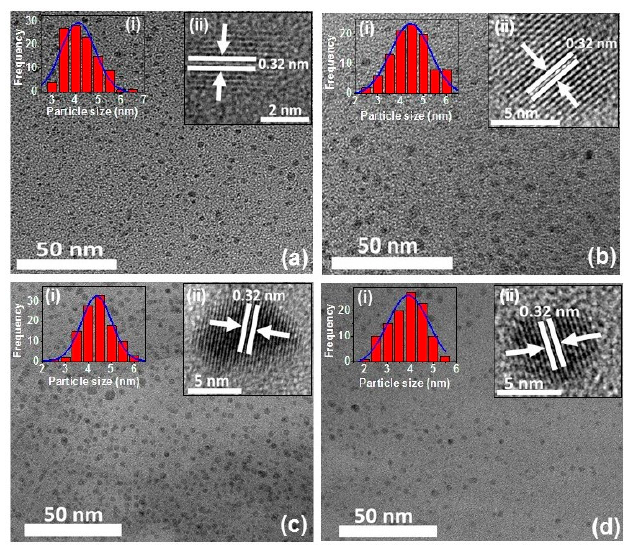
Figure 3. TEM images of ( a ) pear CD, ( b ) avocado CD, ( c ) kiwi CD and ( d ) citrate CD. Insets: (i) Particle size histogram and (ii) the crystalline lattices are identified in each corresponding CD.